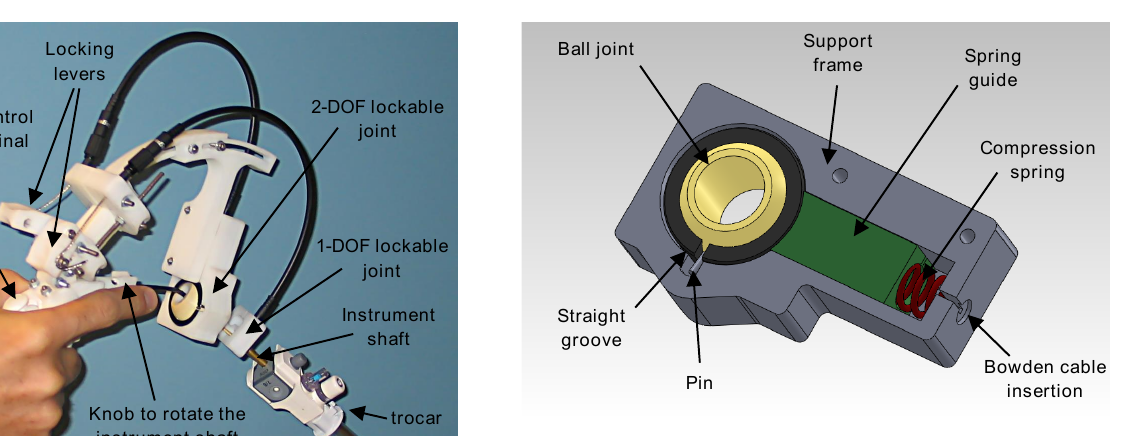
a 2-DOF universal joint and a 1-DOF revolute joint around the shaft longitudinal axis.